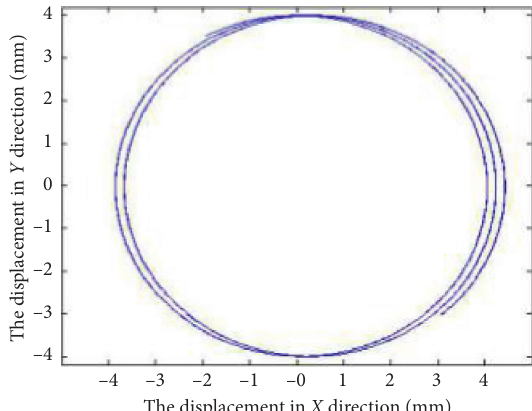
Figure 3: UVARM path diagram of the single